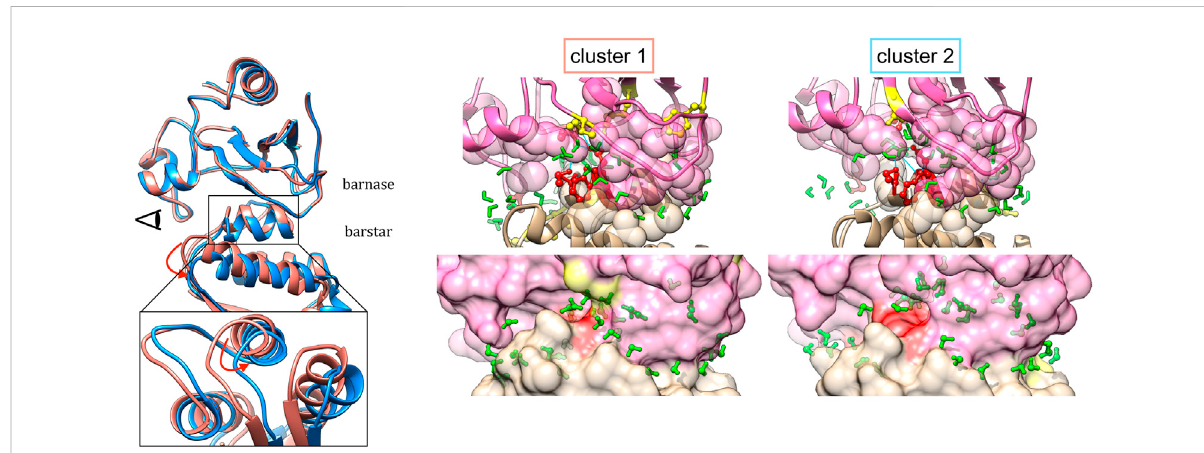
FIGURE 7 Representative structures of interface clusters for the barnase/barstar complex 1BRS. Left part: global superimposition of structure representatives, with cluster one in pink and cluster two in blue and red arrows pointing at main structural variations. The eye symbol indicates the point-of-view for the close-up view at the bottom, where barnase is omitted for clarity. Middle and right part: structure of interfaces in each cluster, with barnase in pink and barnase in beige, and water molecules in green. Interface residues are represented as follows: residues involved